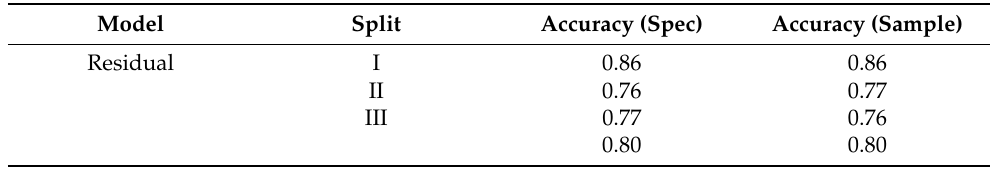
Table 5. Results for neural-network models. Given are the model classification-accuracies for single spectra (spec) and full patient (sample)